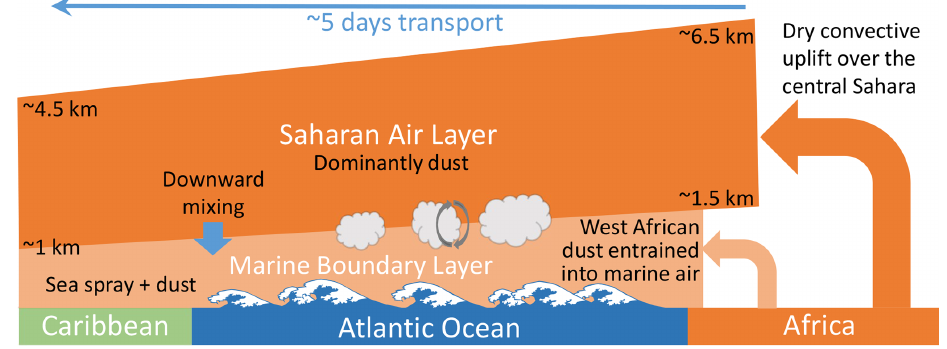
Figure 1. Illustration of the transport of mineral dust from Africa to the summer Caribbean, highlighting transport of dust through the Saharan air layer and also through the marine boundary